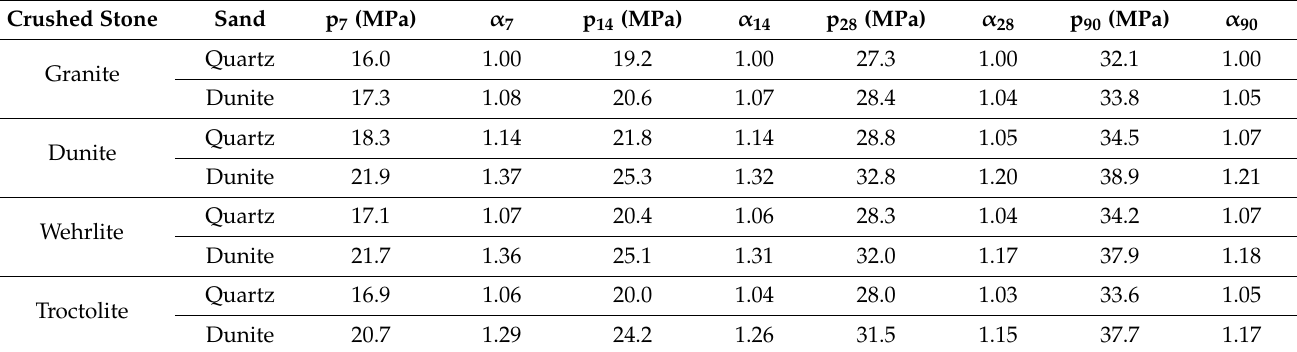
Table 5. Compressive strength of the concrete samples.